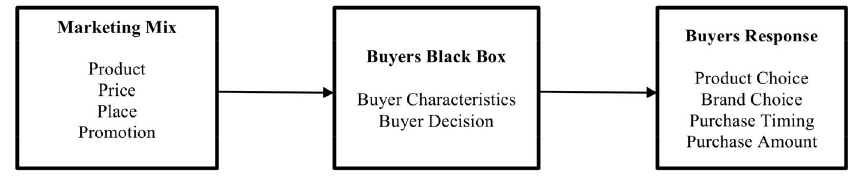
Figure 1. Consumers’ buying decisions (source: Armstrong & Kotler,